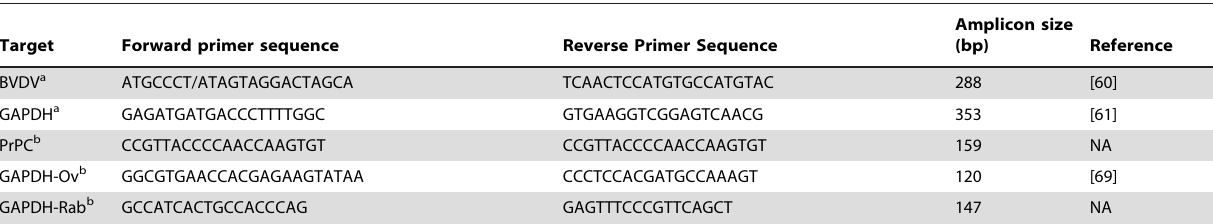
Table 1. RT-PCR primer